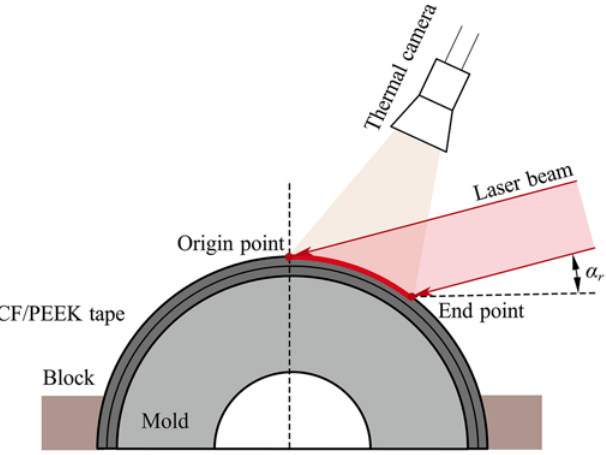
Figure 3. Experimental setup to measure temperature during laser heating the CF/PEEK tape.